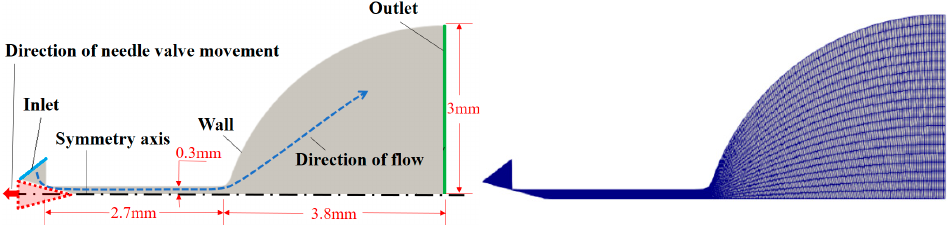
Figure 3. Computational domain ( left side ) and cells ( right side ).